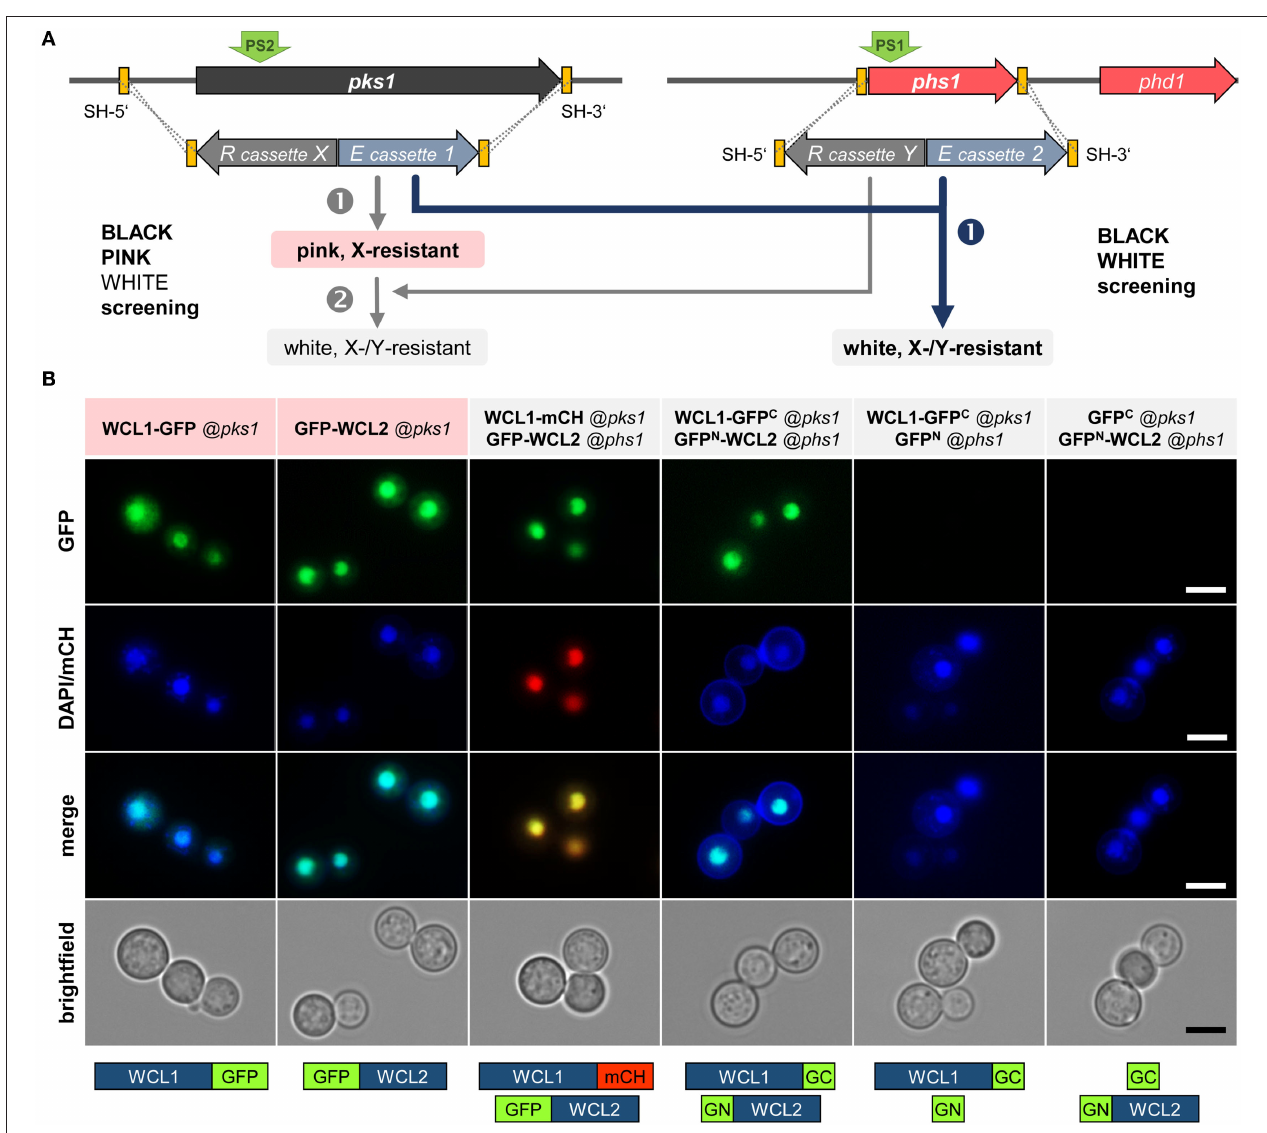
FIGURE 5 | Physical interaction of the K. petricola White Collar transcription factors in the nuclei. (A) Mutation of essential genes for pigment synthesis allows for a two color-based screening of transformants. The color screening in combination with the introduced resistance (R) cassette X/Y enables a rapid identification of transformants carrying the expression (E) constructs 1/2. The integration of two different constructs by replacing pks1 and phs1 can be done stepwise (black-pink + pink-white screening; gray arrows on the left) or in one step (black-white screening; blue arrow on the right). Yellow boxes indicate the SH sequences for targeted integration by HR (dashed lines). For transformation, the constructs are amplified by PCR with primers having target-specific sequences as 5 ′ -overhangs. The green arrows (PS2/PS1) highlight the Cas9 cutting sites. (B) The White Collar transcription factors WCL1 and WCL2 co-localize and interact in the nuclei. The coding regions of wcl1 and wcl2 were amplified from DNA of K. petricola and fused to full-length reporters and gfp fragments ( gfpN , gfpC ) in basal cloning vectors (Schumacher, 2012) ( Supplementary Table 3 ). The expression constructs were amplified with primers containing the sequences homologous to the 5 ′ and 3 ′ -noncoding regions of pks1 or phs1 . WT:A95 protoplasts were co-transformed with expression constructs and pAMA/ribo- pks1 PS2 for single integrations or with pAMA/tRNA- pks1 PS2 - phs1 PS1 for double integrations ( Supplementary Table 4 ). Cell suspensions of pink hygR and white hygR/natR transformants were examined by fluorescence microscopy. Localization/positive controls (lanes 1–2), co-localization (3), bimolecular fluorescence complementation (BiFC) (4), negative controls for BiFC (5–6). Scale bars–5 µ m.